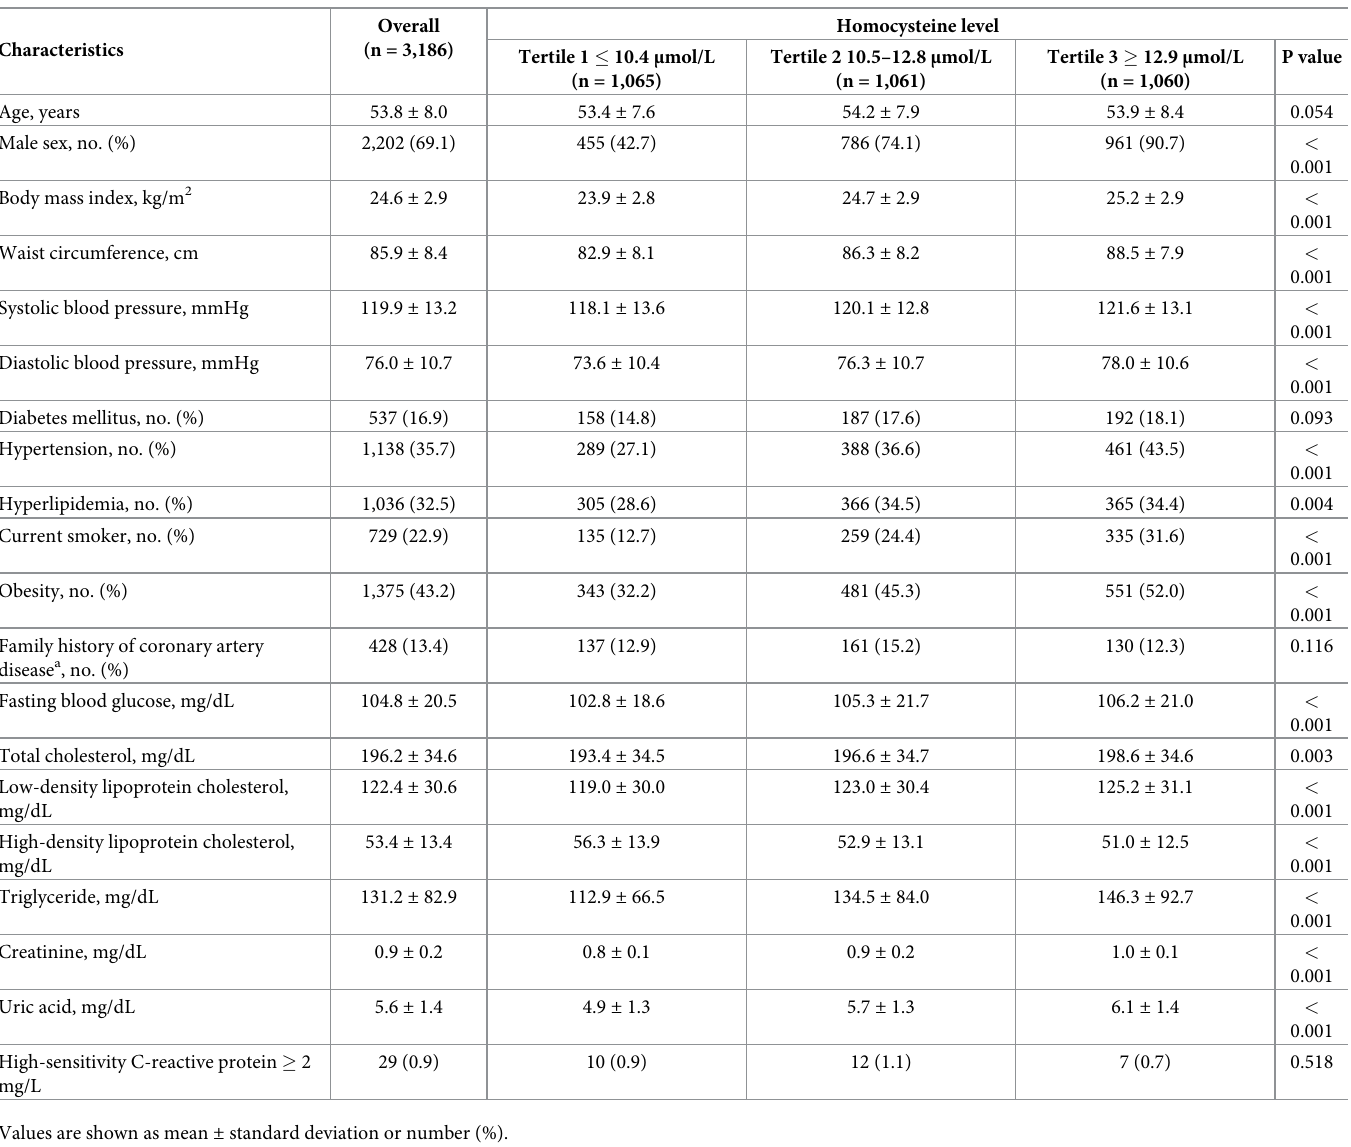
Table 1. Baseline characteristics of the study population according to the tertiles of homocysteine.